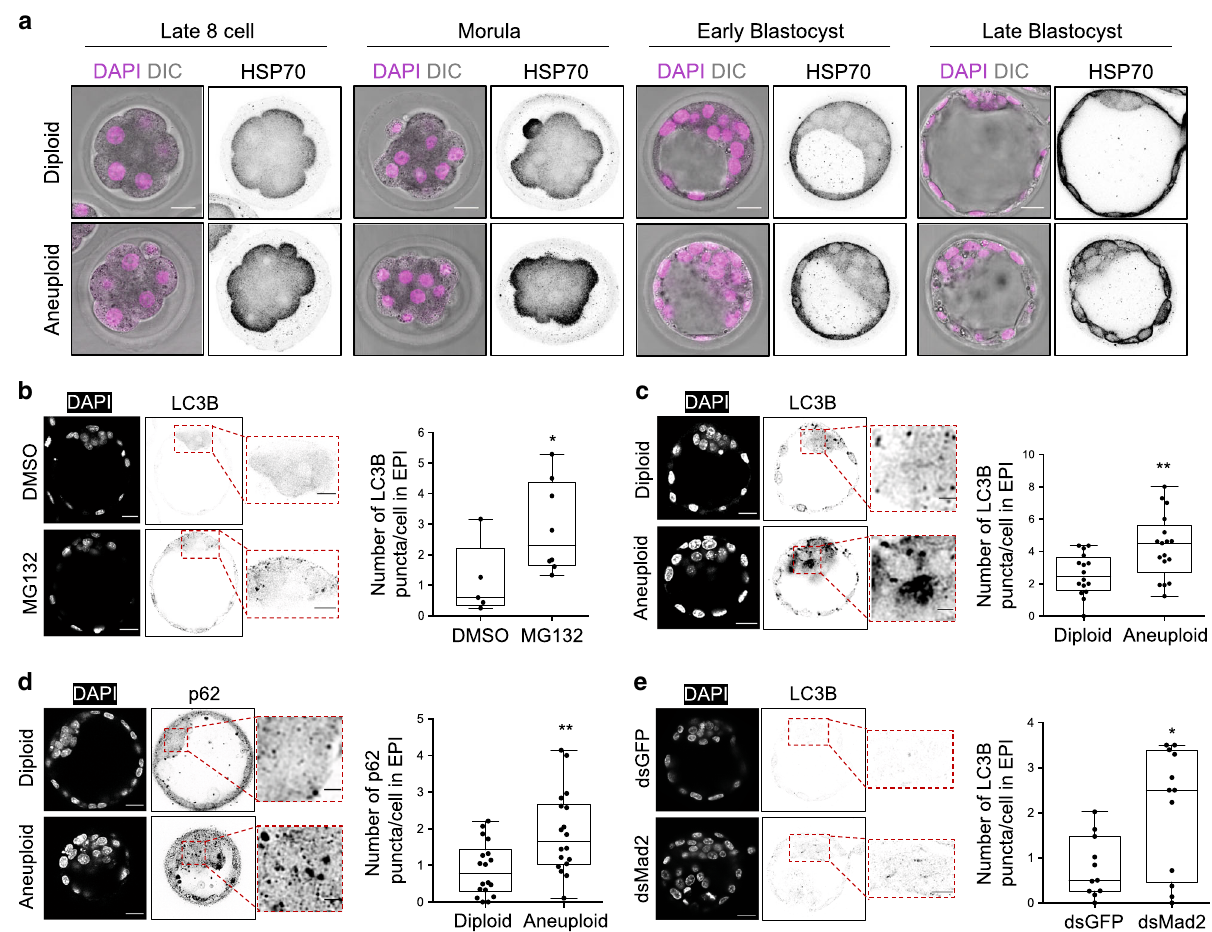
Fig. 4 Chronic protein misfolding and autophagy upregulation in the aneuploid EPI cells. a HSP70 immunostaining in diploid and aneuploid embryos at indicated stages. Scale bars, 20 μ m. Control diploid embryos: 8-cell n = 12, morula n = 9, early blastocyst n = 9, late blastocyst n = 14. Reversine-treated aneuploid embryos: 8-cell n = 10, morula n = 9, early blastocyst n = 9, late blastocyst n = 18. b Embryos were treated with MG132 (or DMSO) at the late blastocyst stage for 6 h and immunostained for LC3B. Each dot represents the average number of LC3B puncta/cell in an embryo. Mann – Whitney test. Control n = 5, MG132-treated n = 8 embryos. Scale bars, 20 μ m. Squares indicate the magni fi ed regions. Scale bars, 10 μ m. * p = 0.0295. Analysis of LC3B ( c ) and p62 ( d ) immunostaining in diploid and aneuploid late blastocysts ’ EPI. Each dot represents the average number of LC3B ( c ) or p62 ( d ) puncta/cell in an embryo. Scale bars, 20 μ m. Squares indicate magni fi ed regions. Scale bar, 5 μ m. For c , diploid n = 16 embryos and aneuploid n = 17 embryos. Student ’ s t test, ** p = 0.0059. For d , diploid n = 18 embryos and aneuploid n = 18 embryos. Student ’ s t test, ** p = 0.0033. e Zygotes were injected with dsGFP (control) or dsMad2 and immunostained for LC3B at the late blastocyst stage. Each dot represents the average number of LC3B puncta/cell in an embryo. Student ’ s t test with Welch ’ s correction, * p = 0.0106. dsGFP n = 11, dsMad2 n = 12 embryos. Scale bars, 20 μ m. Squares indicate the magni fi ed regions. Scale bars, 10 μ m. For graphs b – e , data are shown as individual data points in a Box and Whiskers graph (bottom: 25%; top: 75%; line: median; whiskers: min to max). Source data are provided as a Source Data fi